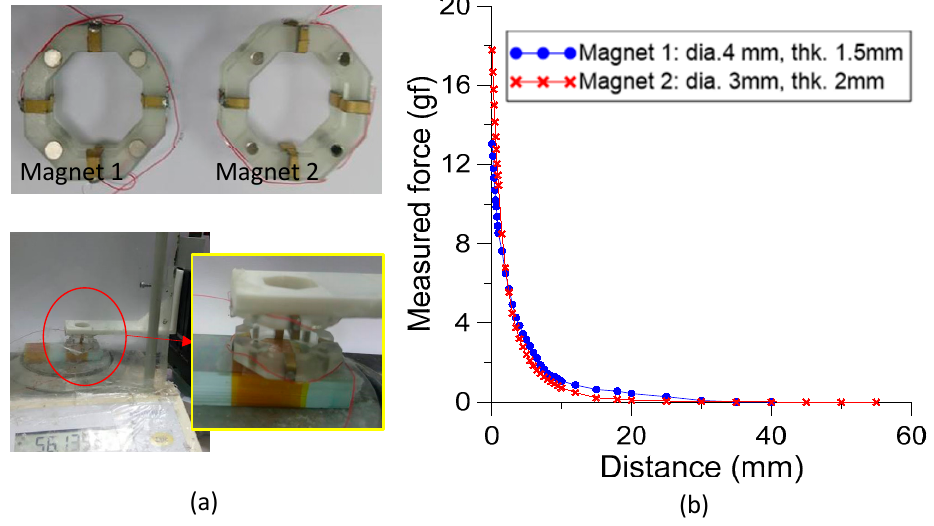
Figure 8. ( a ) Experimental setup for characterizing magnetic force between the frame pair. ( b ) Measured results of using different magnet pairs.